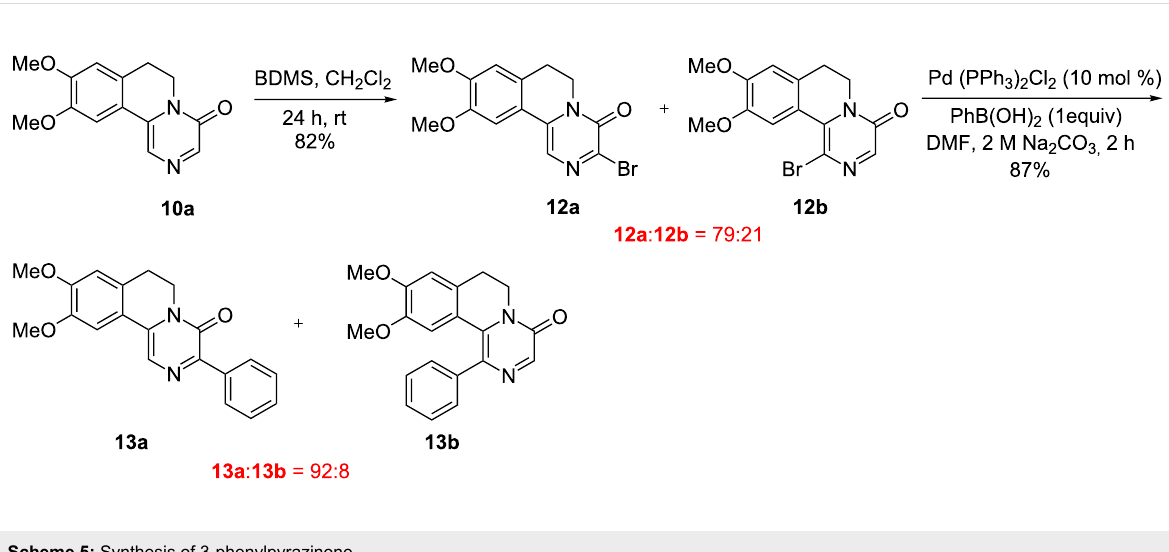
Scheme 5: Synthesis of